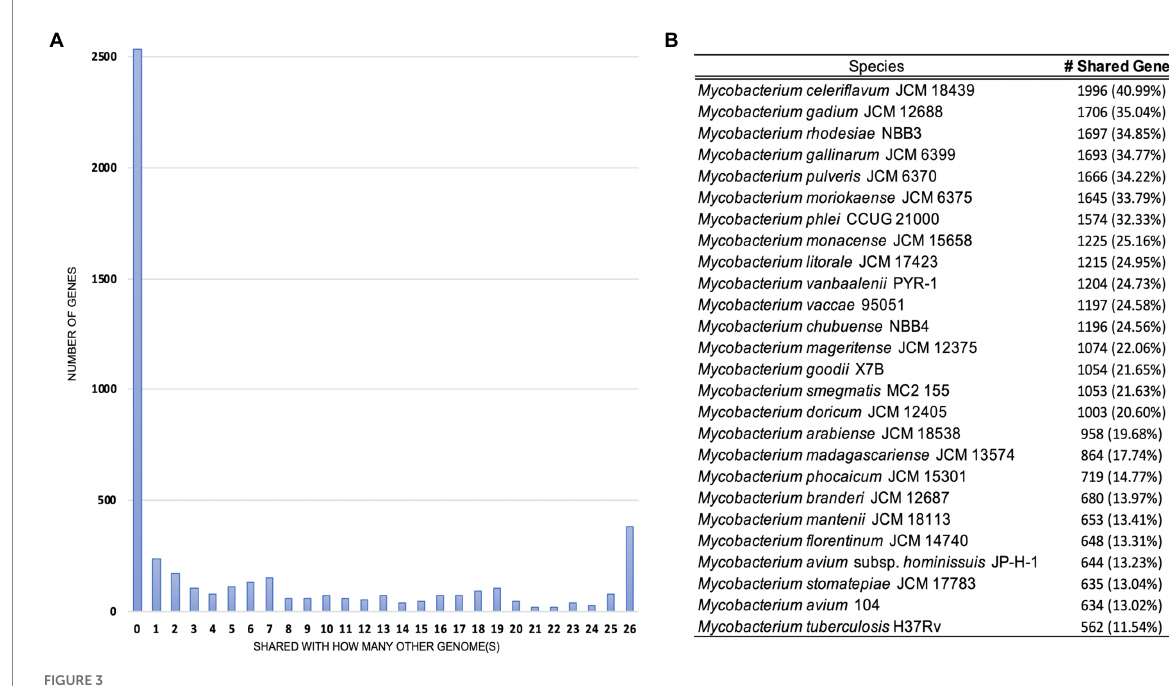
FIGURE 3 (A) Number of genomes in which genes in strain 20-157661T have homologous sequences. The first bar on the left-hand side represents genes unique to strain 20-157661T (48%) while the last bar on the right represents the core genomes, i.e., genes present in all the analyzed genomes (7.8%). (B) Number of homologous strain 20-157661T genes shared by each of the genomes in our dataset. Homologous genes were defined as being at least 85% identical over their aligned protein